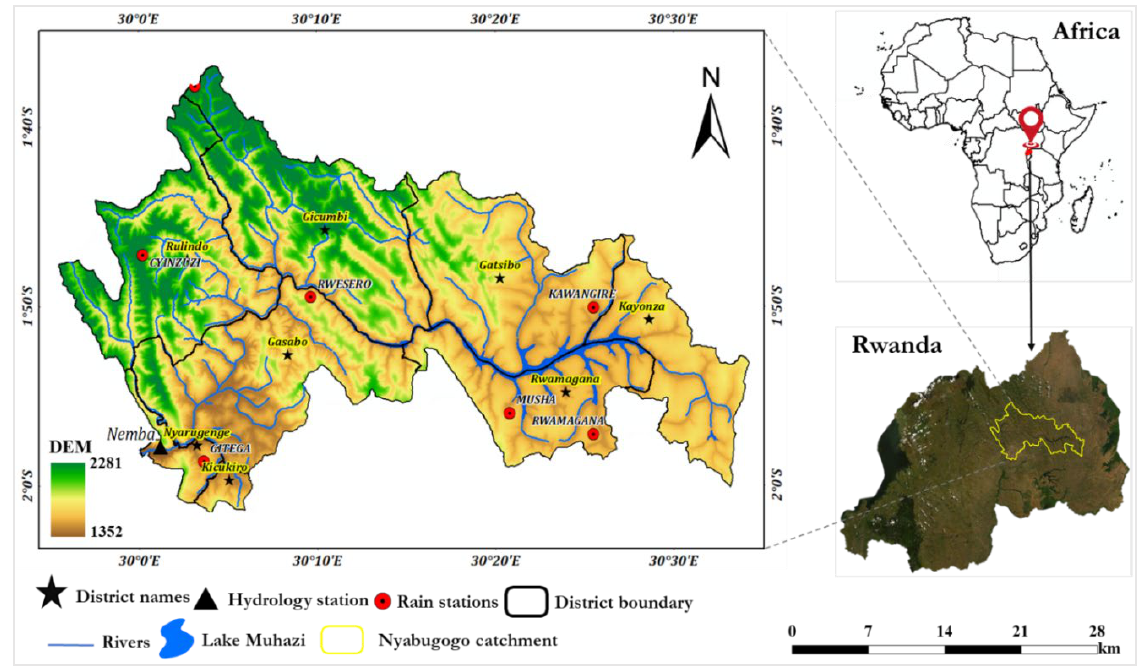
Figure 1. Location of Nyabugogo catchment in Rwanda. The Nyabugogo catchment, similar to the rest of the country, has a temperate tropical climate, with mean annual precipitation ranging from 992 mm to 1128 mm, average annual Rwanda has two rainy and dry seasons. For rainy seasons, one is from the end of September to December, while the peak rainy season is from March to early May. The Nyabugogo